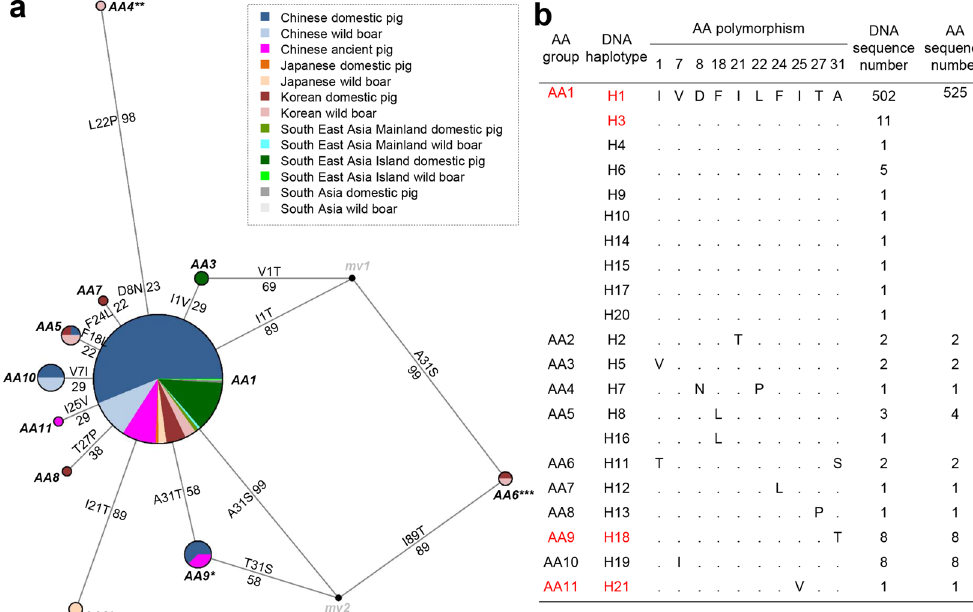
Figure 3. Ancient Cytb gene analyses. Relationship of pig Cytb amino acid sequences. ( a ) Each haplogroup is represented by a circle, with the area of the circle proportional to the haplogroup’s frequency. Different colors indicate samples originating from different regions. The numbers alongside AA changes are the Grantham scores which help classify the conservation levels of AA changes. The number of asterisks highlights the level: non - considered conservative; one - moderately conservative; two - moderately radical and three - radical, respectively. ( b ) Alignment of AA changes among the 11 AA haplogroups and 21 DNA haplotypes. The AA haplogroups and DNA haplotypes containing ancient pigs are in red